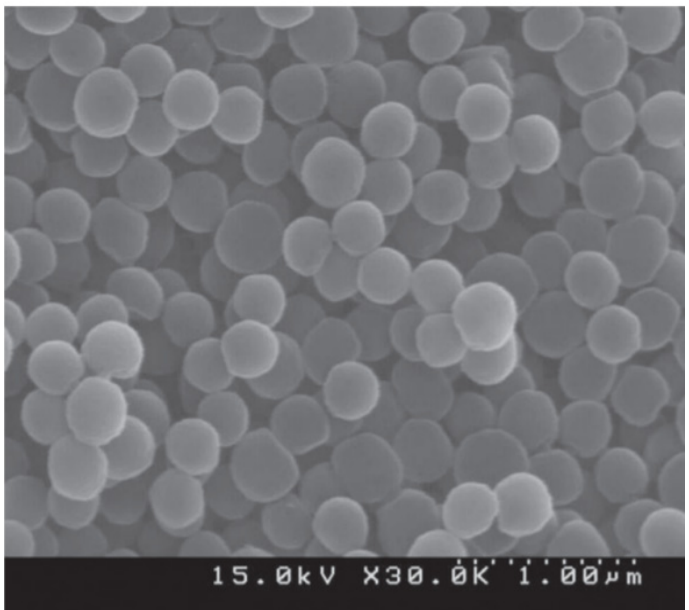
Figure 1. SEM image of nano-sized PMMA spherical beads synthesized by suspension polymerization with